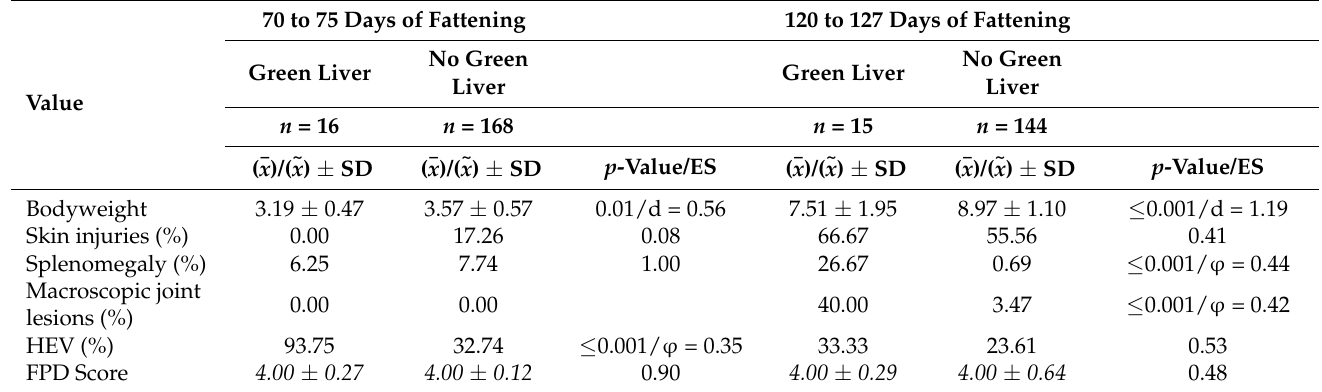
Table 1. Comparison of different values for all 343 female Bronze turkey individuals with and without green liver discoloration in the early (70 to 75 days of fattening) and late (120 to 127 days of fattening) fattening stages, respectively. The presented data includes means ( x ), medians ( (cid:101) x ), standard deviations (SD), p -values, and (if applicable) effect sizes (ES) within the same age